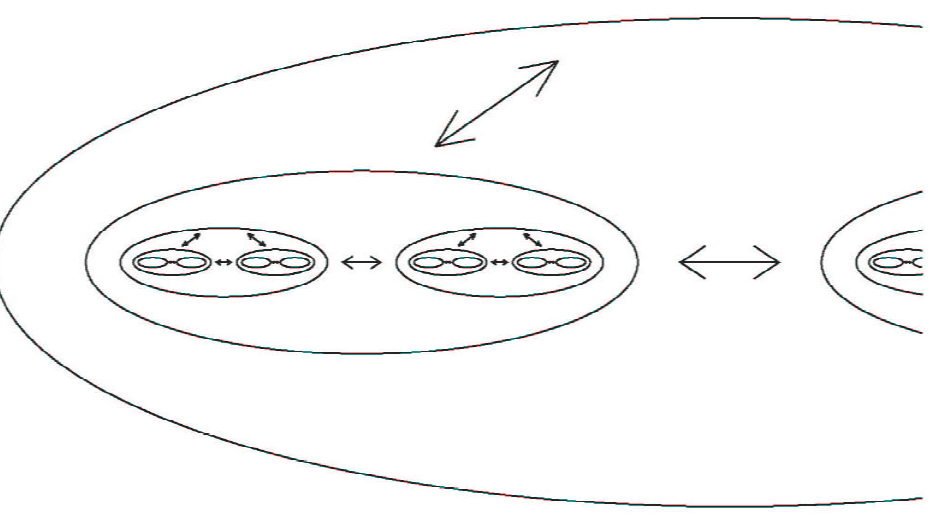
FIGURE 1. The fractal organization of the living organism, with parts that interact, and by this forms a number of levels. The arrows illustrate information-transmitting interactions and are generalized from the empirical findings. This illustrates how biologic systems act as a fractal kind of Chinese box containing the information-transmitting interactions between the different parts of the same